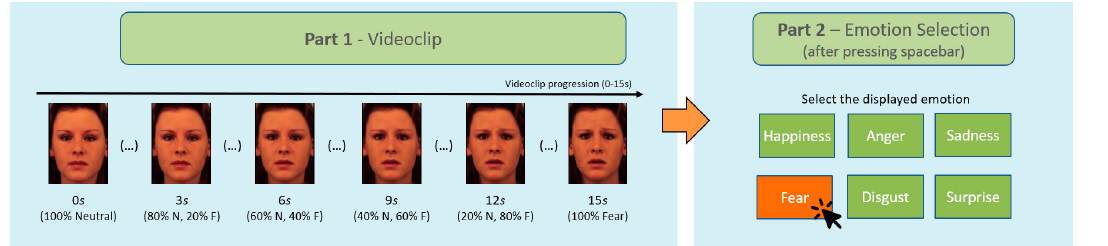
Figure 1. Trial scheme of the facial emotion recognition Task.